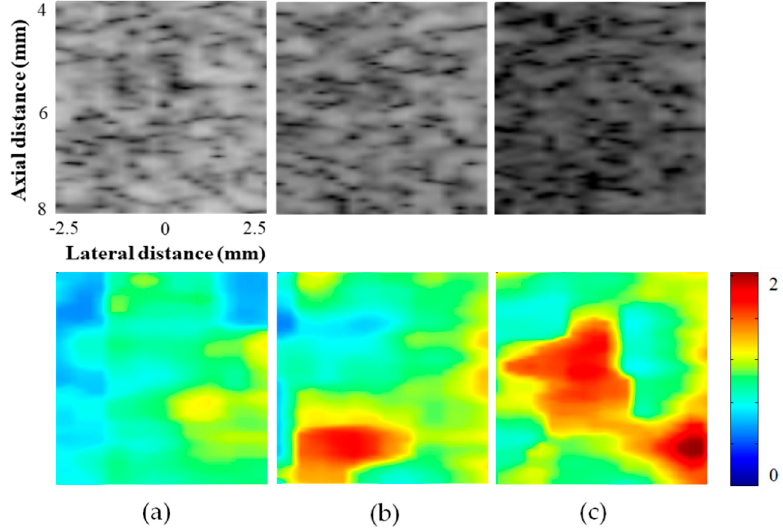
Figure 3. Ultrasound B-mode images and corresponding Nakagami images from the tissue-mimicking phantoms with di ff erent scatterer concentrations of ( a ) 3, ( b ) 6, and ( c ) 10 %. The phantoms with higher scatterer concentrations yielded higher Nakagami parameter values.